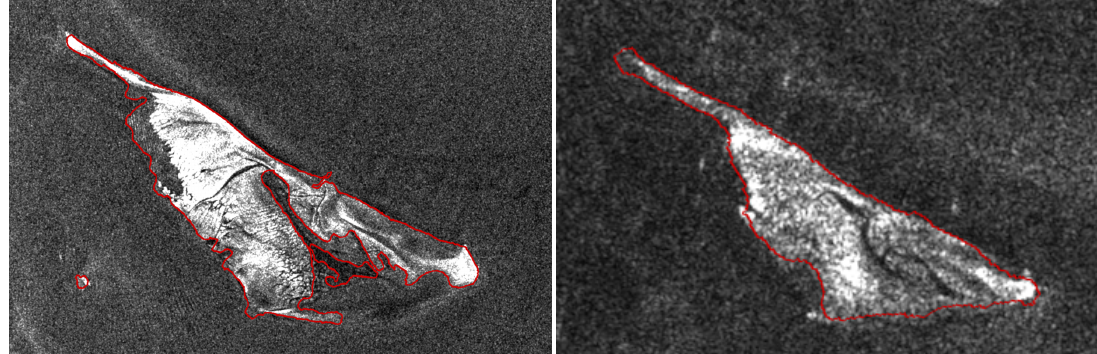
Figure 4: Full resolution comparison of the TerraSAR-X SM scene (left, 2 . 75 m pixel spacing) and the Sentinel-1 IW scene (right, 10 m pixel spacing). The red lines indicate the boundaries found by our algorithm.